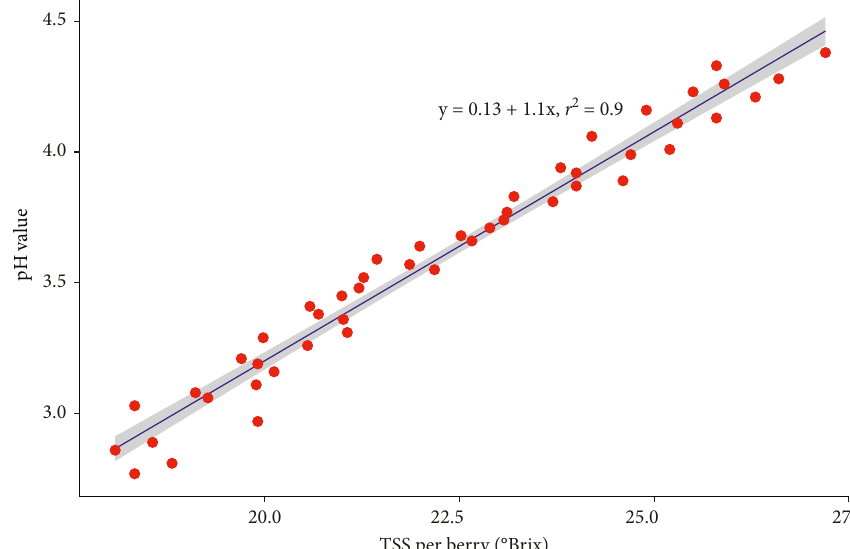
Figure 11: Correlation between TSS per berry and pH of grape juice. Table 1: Interaction effect of pruning level and post-veraison water stress on Merlot grapevine total anthocyanins and phenols. Pruning level